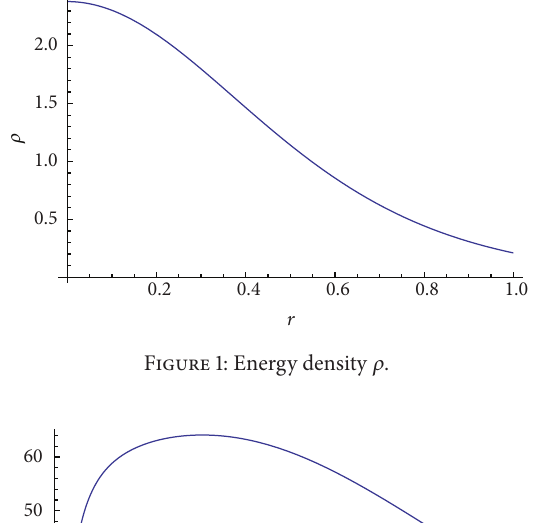
Figure 1: Energy density 𝜌 .